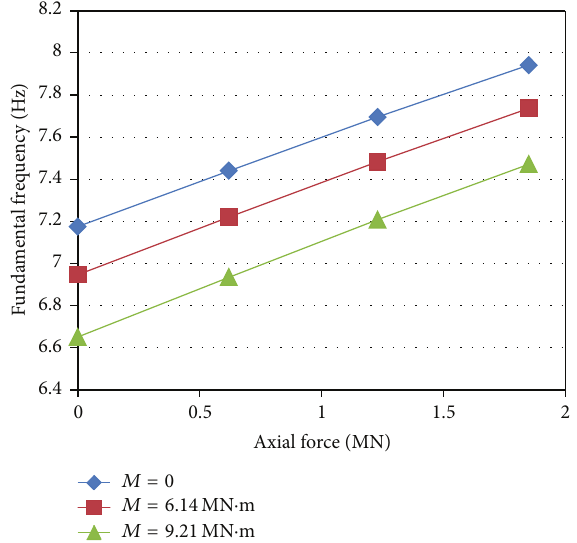
Figure 6: Variation of the fundamental frequency with tensile force and end moment; pinned-pinned (P-P) boundary condition.